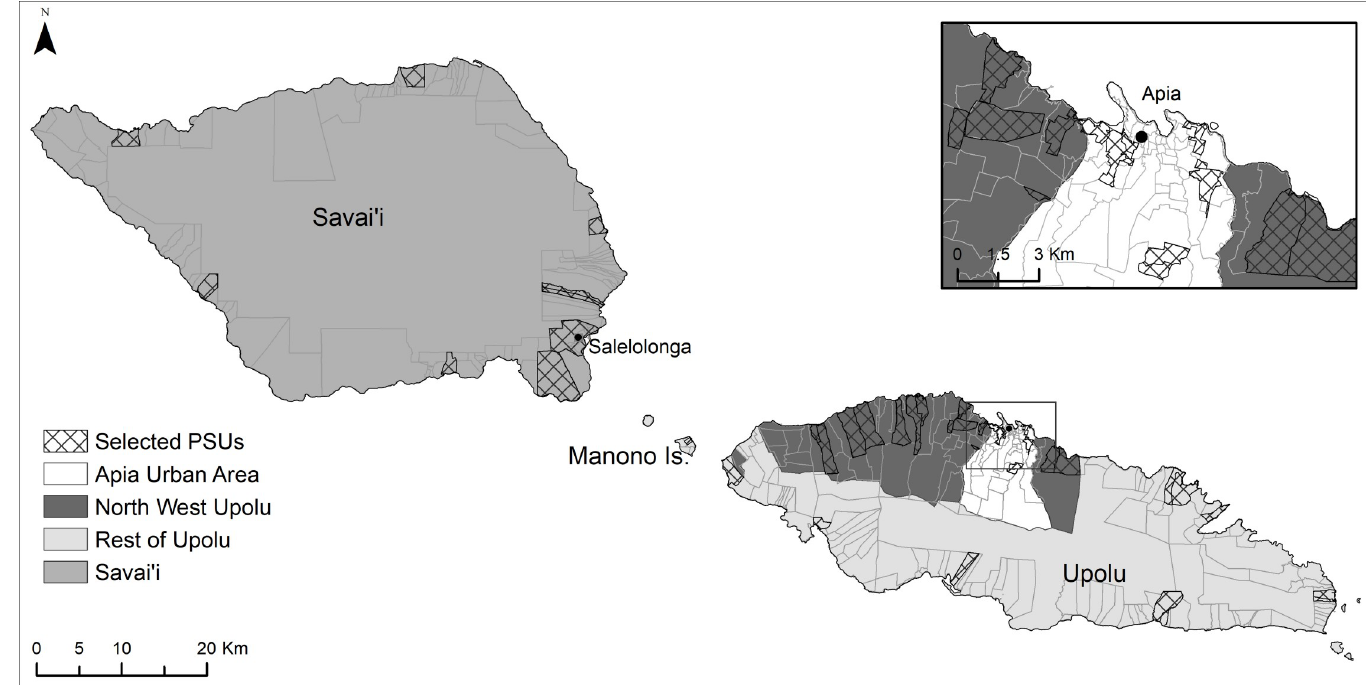
Fig 1. Map of Samoa with administrative region boundaries and selected